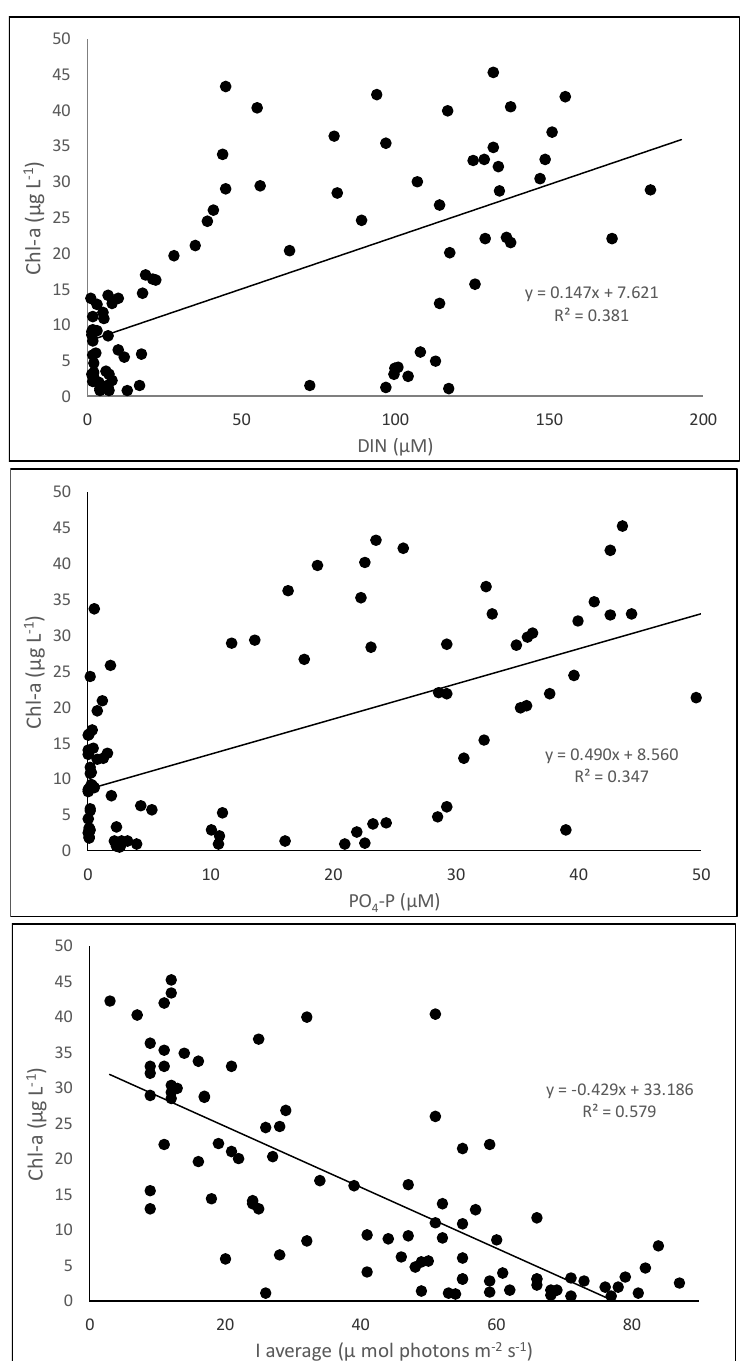
Figure 8. Linear regressions between dissolved inorganic nitrogen (DIN) and chlorophyll-a (Chl-a) (upper chart), phosphates and chlorophyll-a (Chl-a) (middle chart), and light and chlorophyll-a (Chl-a) (lower chart) based on combined data from 2001–2019.